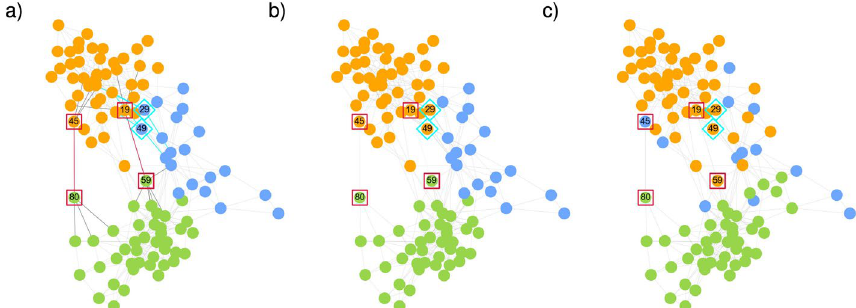
Table 2 The network of POLBOOKS (Experiment 2)